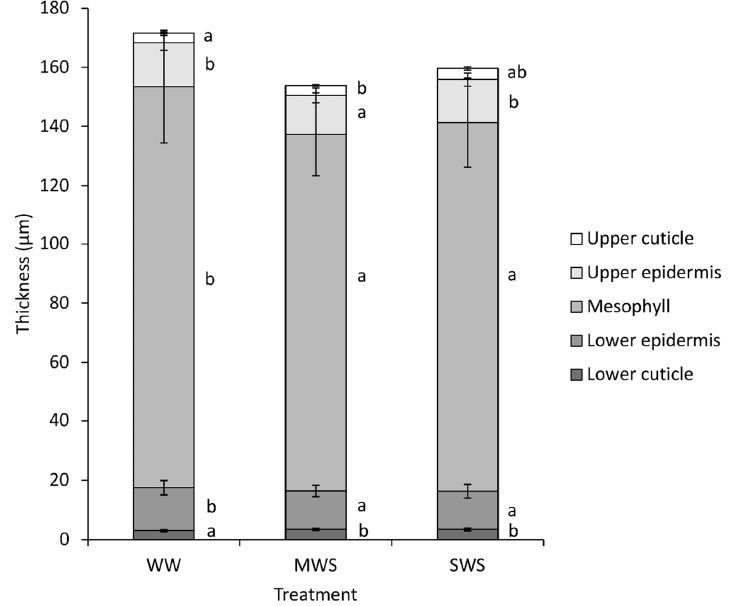
Figure 5. Proso millet leaf tissue thickness (sampled on day 26) for the three water treatments. The data are means ± SD ( n = 5). Different letters indicate significant differences within each tissue type across the treatments ( p ≤ 0.05; Duncan tests).